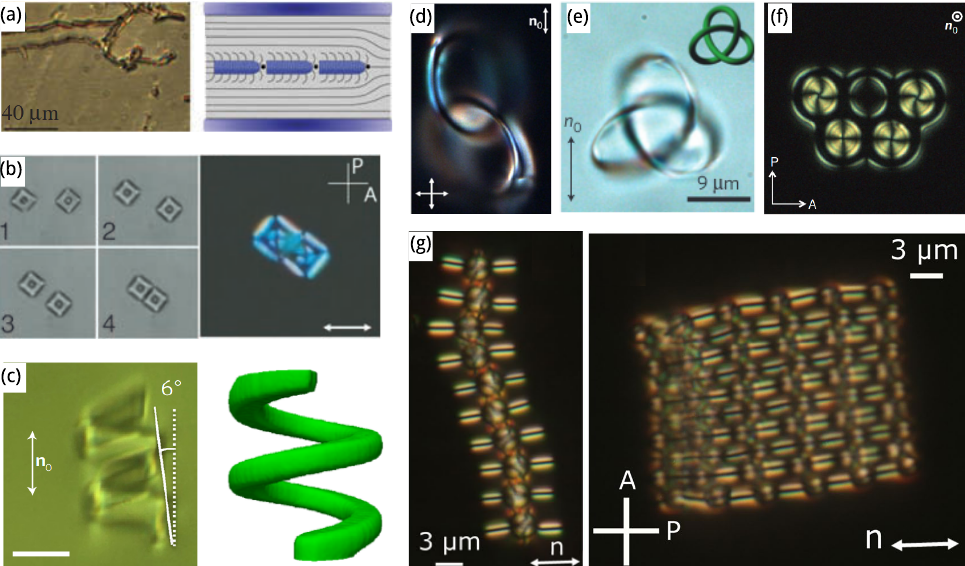
Figure 6. Nematic colloids with different particle shapes. Structures show different assembly charac- teristics, mediated by both the defects and the elastic deformation of the director field. Geometry and topology of the particles play a strong role in the behavior of the nematic host and can be tuned to achieve desired goals. Images are reprinted and adapted with permission from the